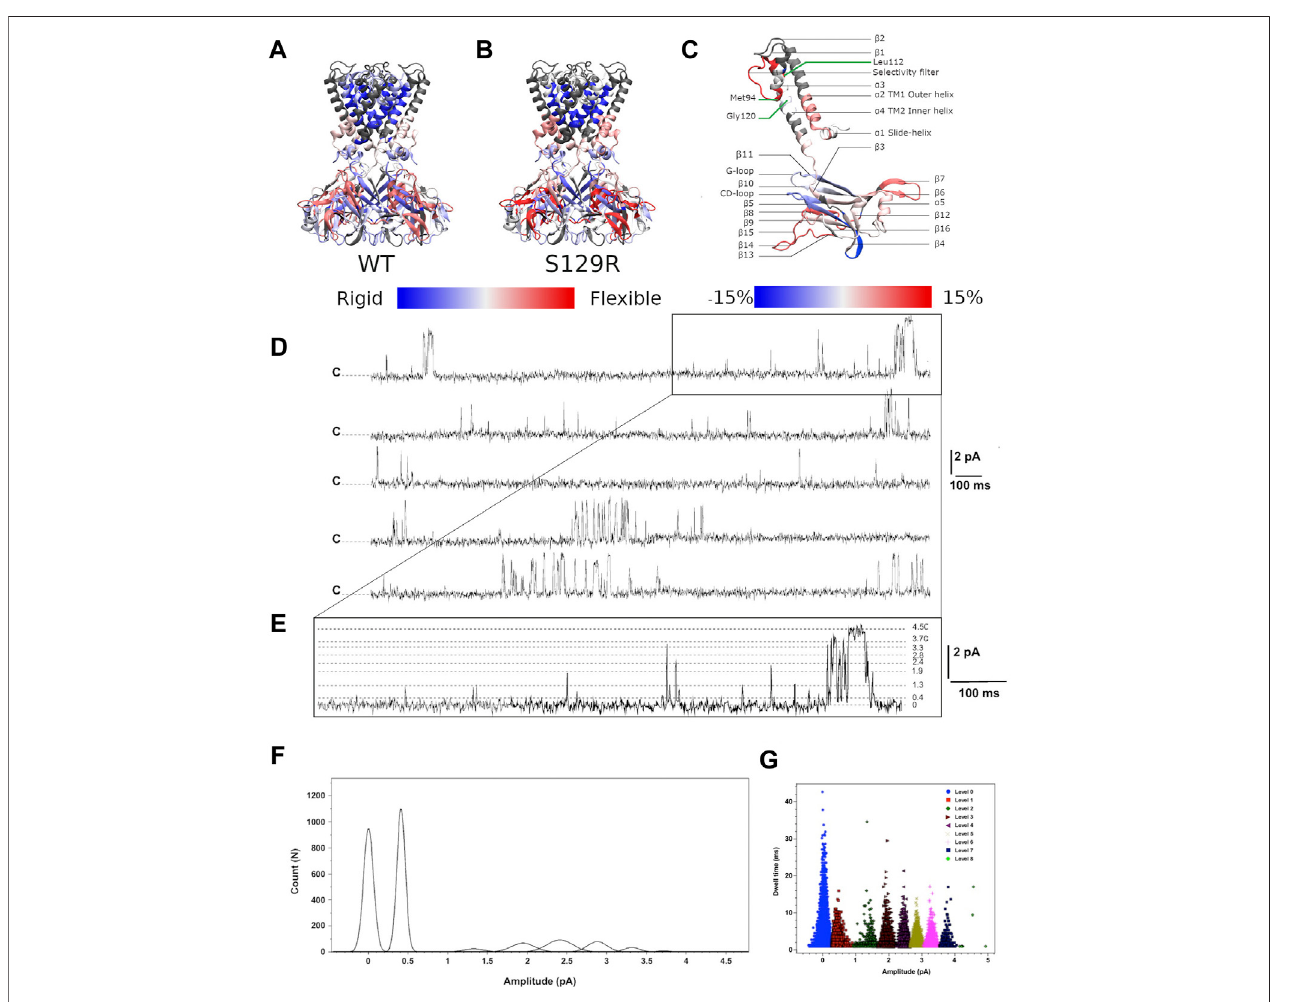
FIGURE 2 | HDX-MS and single channel recordings HDX-MS rates of peptides reported for (A) KirBac3.1 WT (Forest et al., 2016) and (B) the mutant S129R. Identi fi ed peptides are drawn with blue (low exchange and low fl exibility) to red (high exchange and high fl exibility) color according to their percentage of deuterium exchange after 1,200 s (scale of exchange shown at the bottom of the fi gures). (C) Nomenclature of secondary structures and rate of exchanges between the mutant S129R and KirBac3.1 WT. Scale of deuterium exchange rate is shown at the bottom of the fi gures, same color code as for A and B. Red appears when S129R is more fl exible than WT and blue when S129R is more rigid than WT (D) Single channel recordings from KirBac3.1 S129R channels, traces obtained from 6 min consecutive recordings at +150 mV holding potential. Closed state is labeled c (E) , an enhancement of the upper trace to show the multiple sub states induced by the S129R mutant (F) amplitude histogram fi ts(Gaussian) of all events for theselected levels gating between closed and open states during 6 min (G) S129Rchannels gate with multiple subconductance states. Dwell time for all events at 150 mV test potential is plotted for all current levels.